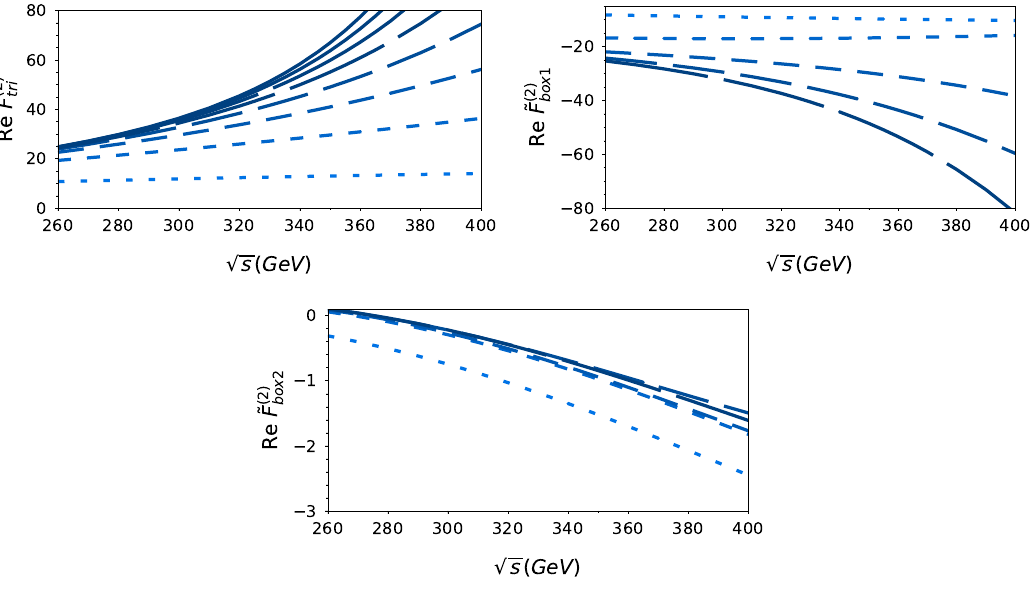
p s for r p = 0 : T